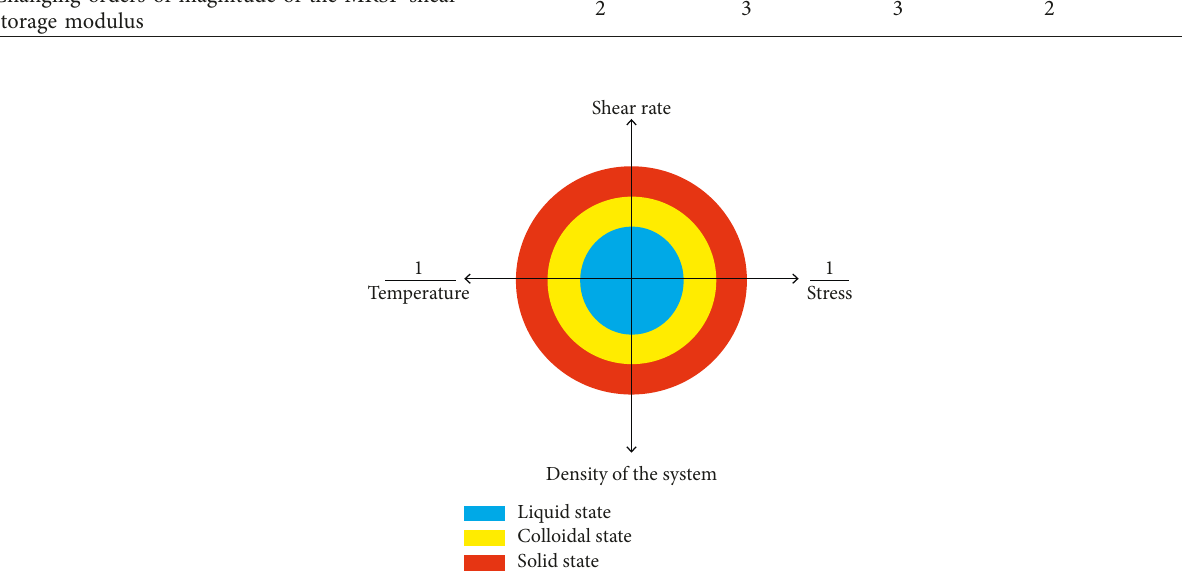
Figure 6: The phase change diagram and the influence factors of